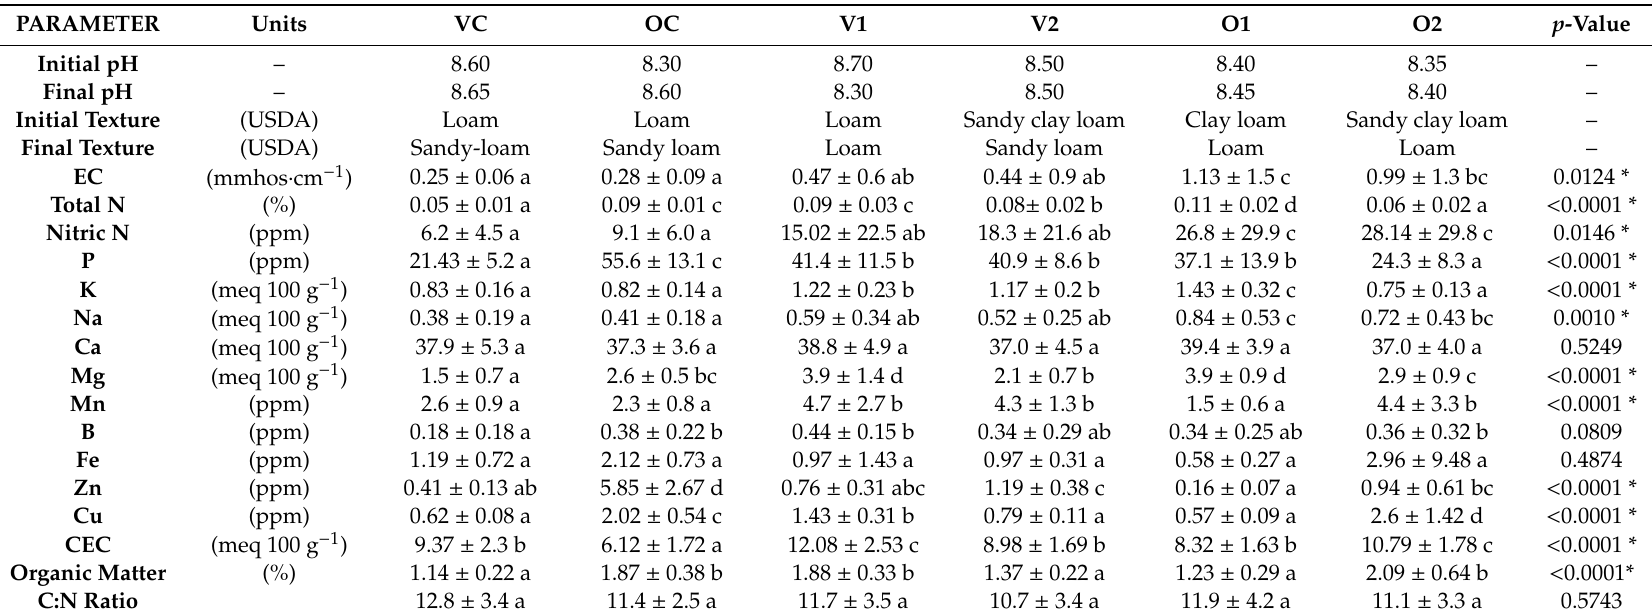
Table 4. Di ff erences among plots for soil